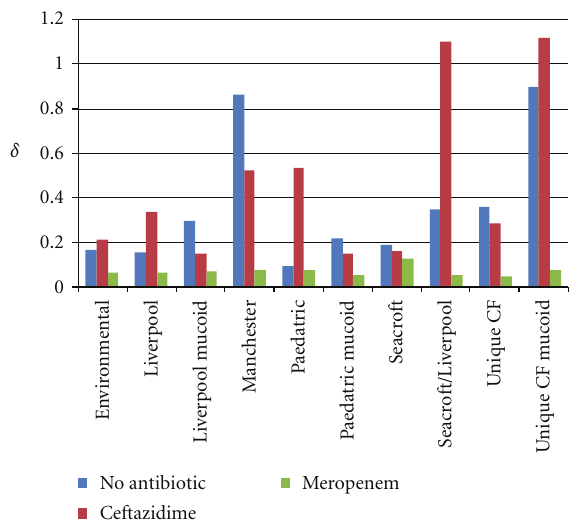
Figure 2: Values for δ determined from the Weibull distribution using a fixed value for the scale parameter p with preincubation with no antibiotic ( δ ), ceftazidime ( δ cef ), and meropenem ( δ mero